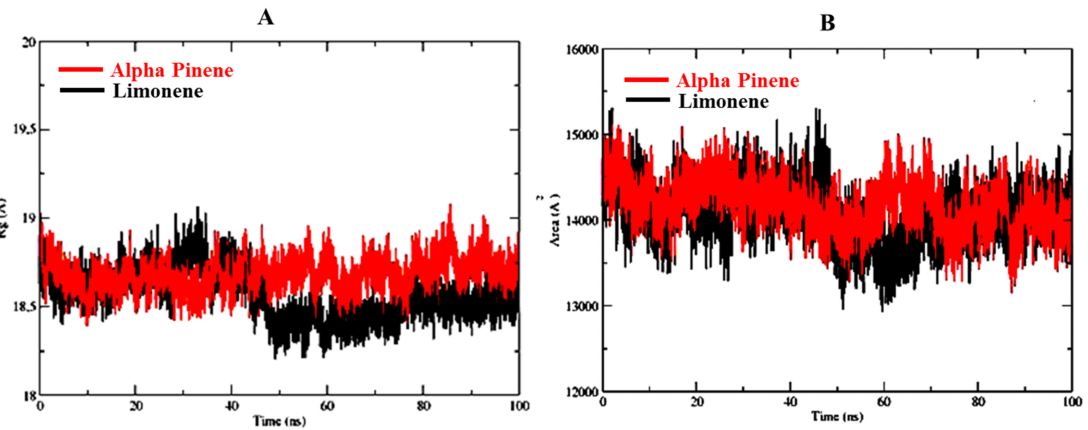
Figure 6. ( A ) Radius of gyration (ROG) and ( B ) Solvent Accessible Surface Area of the best protein- ligand complexes. Red is indicating D-limonene and black is indicating α